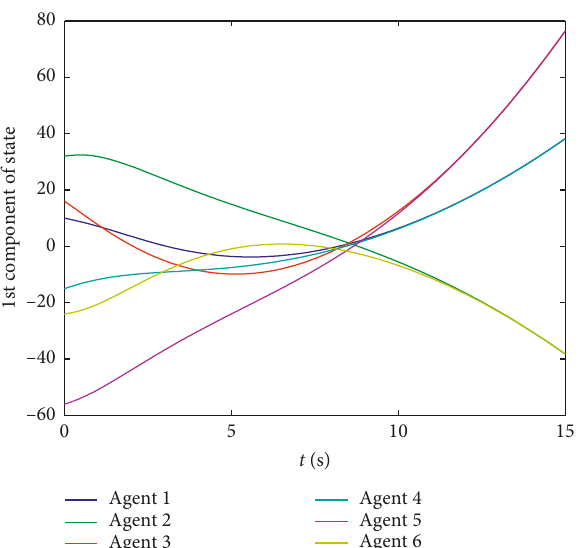
Figure 7: Trajectories of x